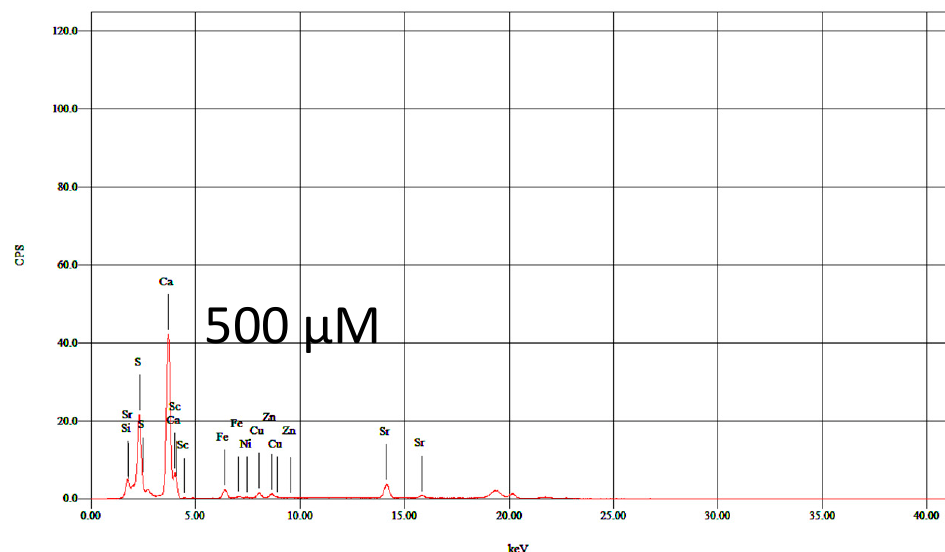
Figure 2. XRF analysis of phosphate waste before treatment.